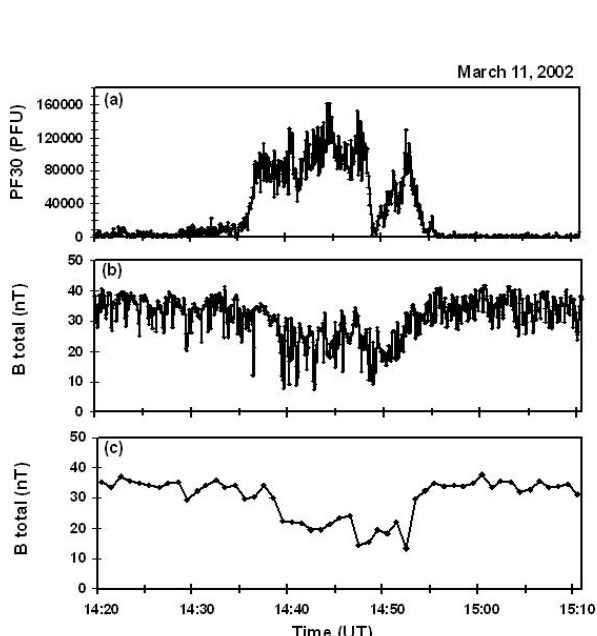
Fig. 2. The expanded time interval from 14:20UT to 15:10 in Fig. 1 for 11 March 2002 to illustrate large variations within the depressed magnetic field region. Panels show 4s PF30 (a) , and 4s and 1min magnetosheath magnetic field (b, c)